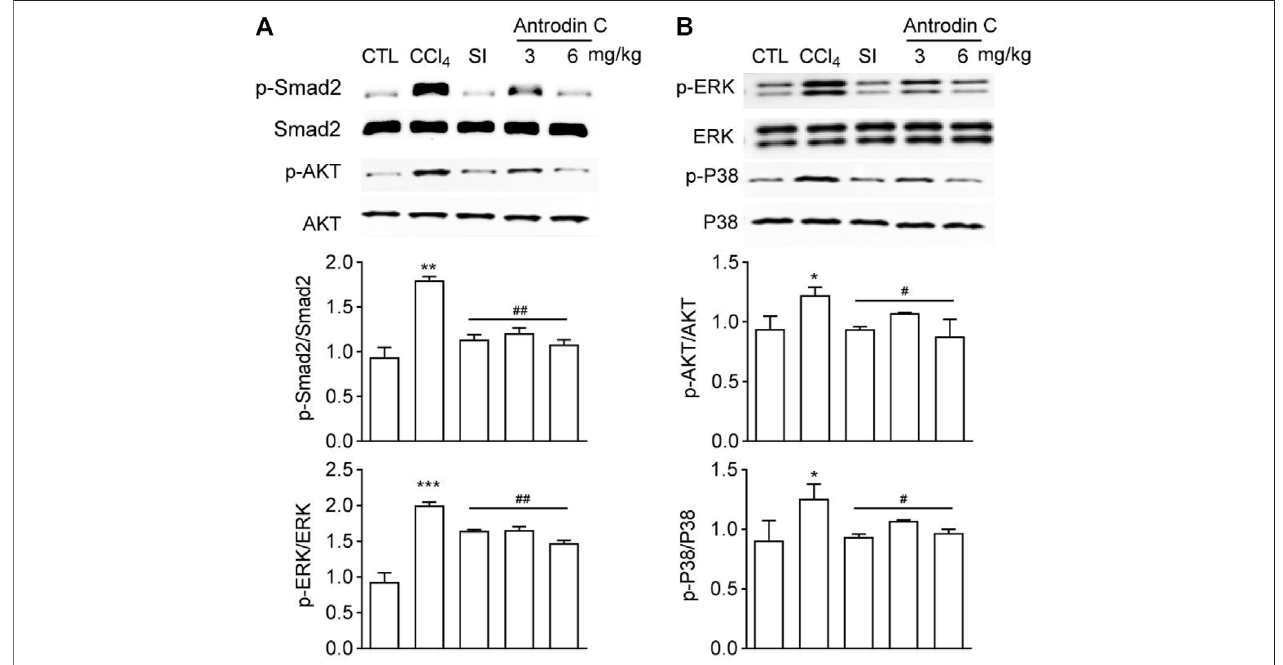
FIGURE 7 | Effects of Antrodin C on phosphorylation of Smad2, AKT, ERK, and P38 in the livers of CCl 4 -treated mice. (A,B) Western blot analysis of phosphorylated and total Smad2, AKT, ERK, and P38 in livers tissues. Total Smad2, AKT, ERK, and P38 were used for normalization, respectively. Data represent mean ± SD ( n = 6), * p < 0.05, ** p < 0.01, *** p < 0.001 compared with control group; # p < 0.05, ## p < 0.01 compared with CCl 4 -treated group. CTL: the control group;